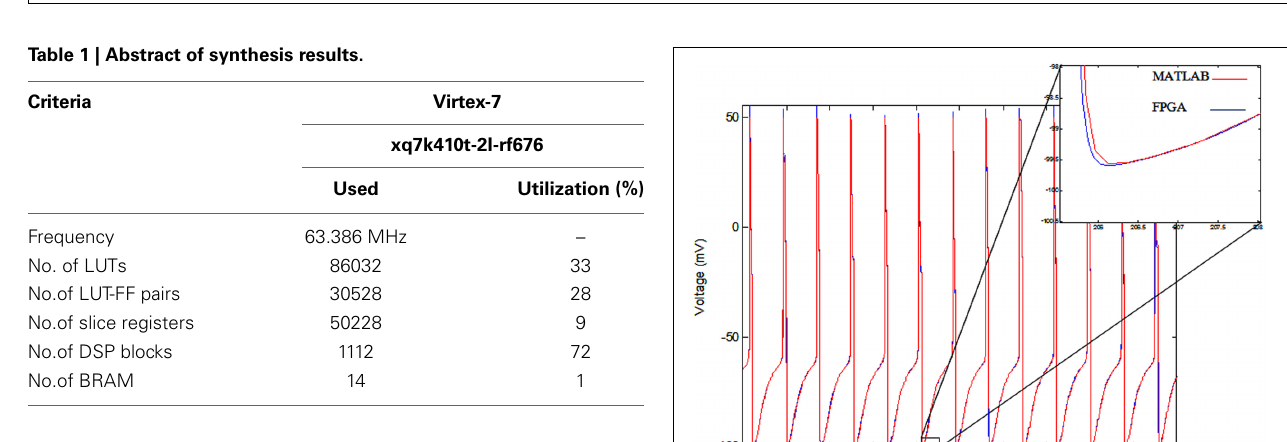
FIGURE 10 | The designed controller, which is used to control the neural network.